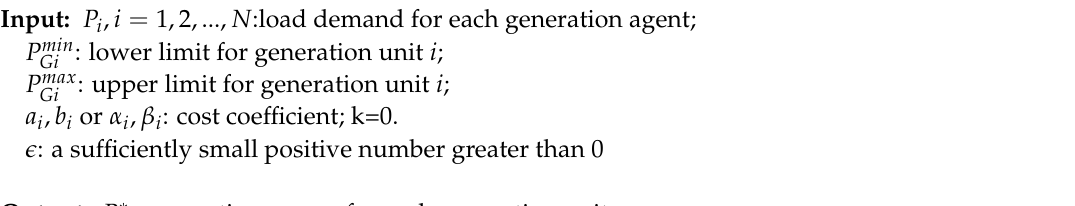
Algorithm 1 Distributed half-search